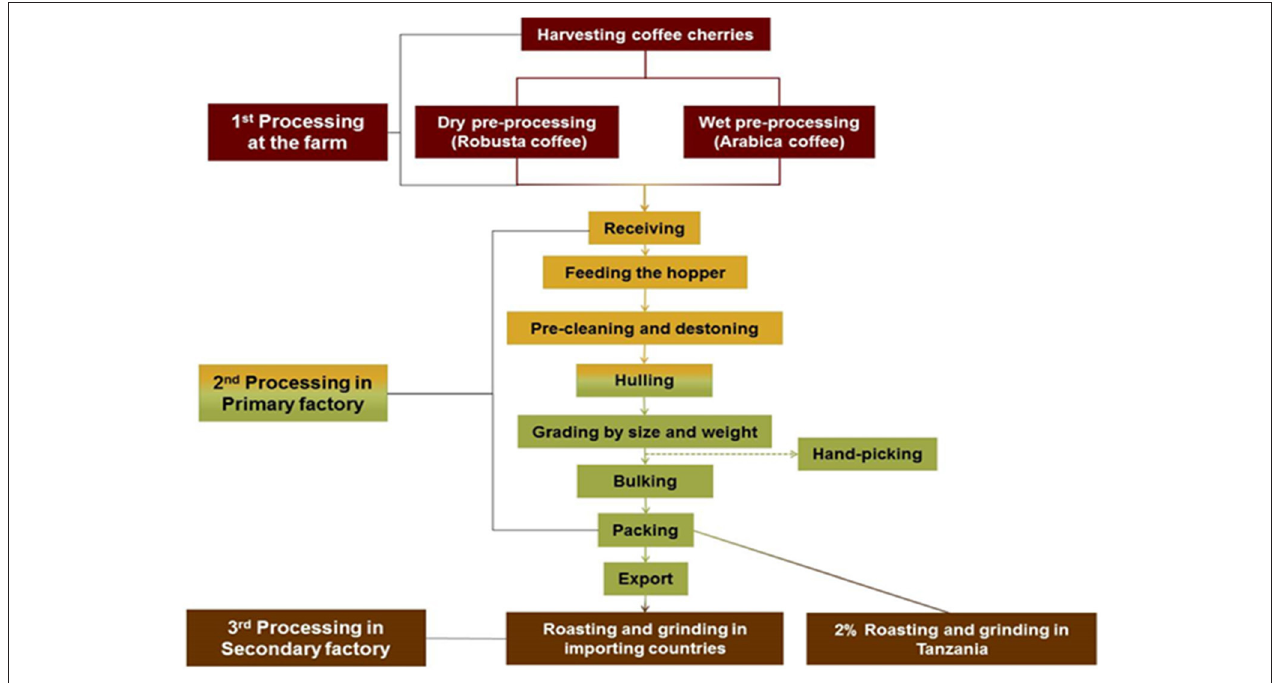
FIGURE 1 | Schematic diagram for coffee processing in Tanzania